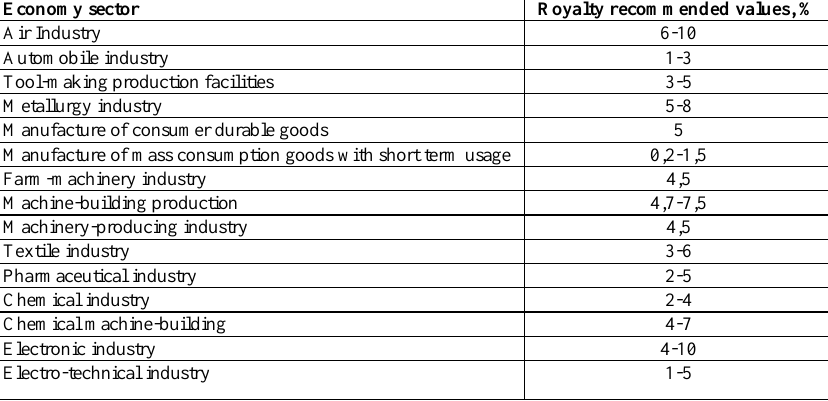
Table 4. Recommended royalty